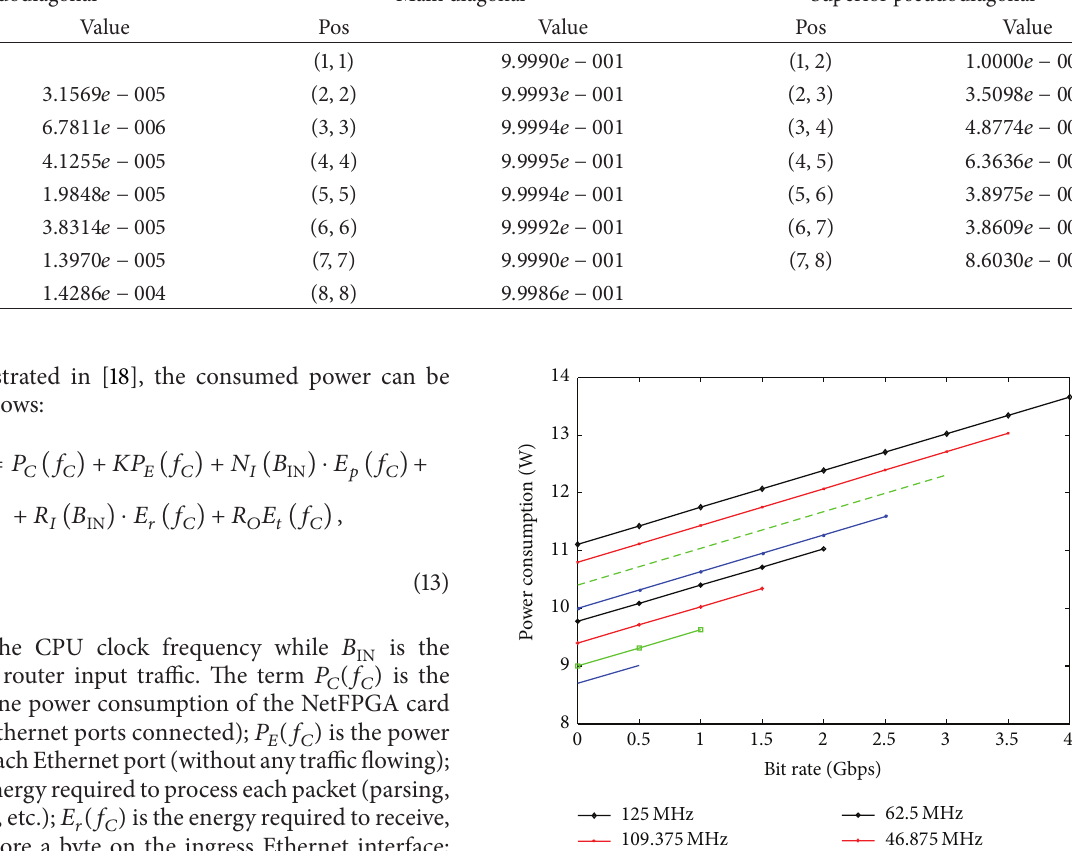
terms of the main diagonals are then calculated such that the sum of each row is equal to one. In this way the traffic modeled by 𝑇 1 and 𝑇 2 result less correlated than the measured traffic, the traffic modeled by 𝑇 3 coincides with the real traffic, while the other models represent more correlated traffic. (𝐼) , Γ (𝐼) ) , with 6 ≤ 𝑖 ≤ 10 , characterized by (ii) 𝑇 𝑖 = (𝑄 𝑖 the same five transition probability matrices of